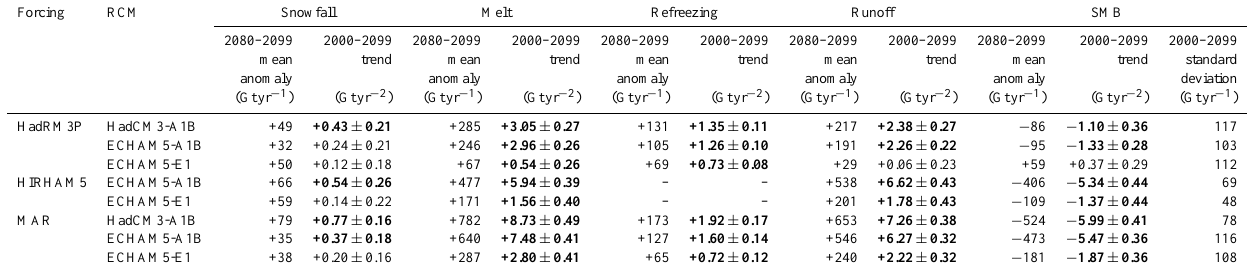
Table 6. Snowfall, melt, refreezing, runoff and SMB in the future RCM simulations. 2080–2099 means, expressed as anomalies relative to 1980–1999 means from the appropriate recent-past simulations; and 2000–2099 trends. Trends which are different from zero at the 2 σ confidence level are shown in bold. For SMB, 2000–2099 standard deviation is also